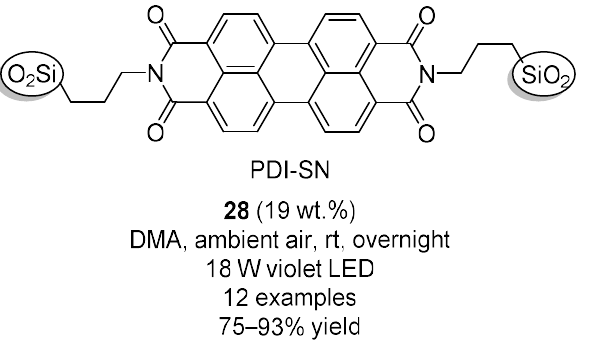
Figure 3. Results obtained in the photo-oxidative dehydrogenation of tetrahydroquinolines and other N -heterocycles to render 13 and 14 catalyzed by 28 .